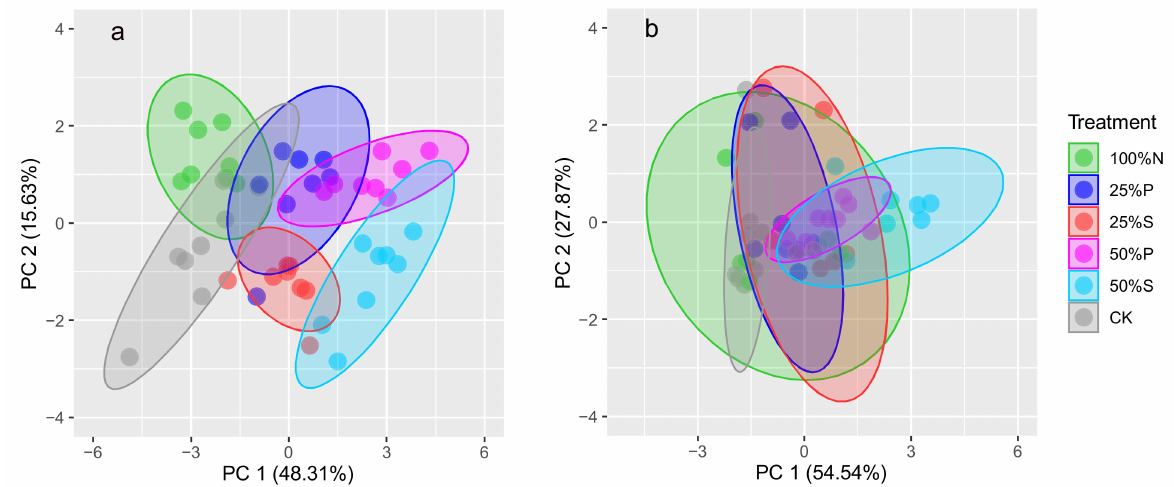
Figure 2. Principal component plots of ( a ) soil quality and ( b ) antibiotics with different